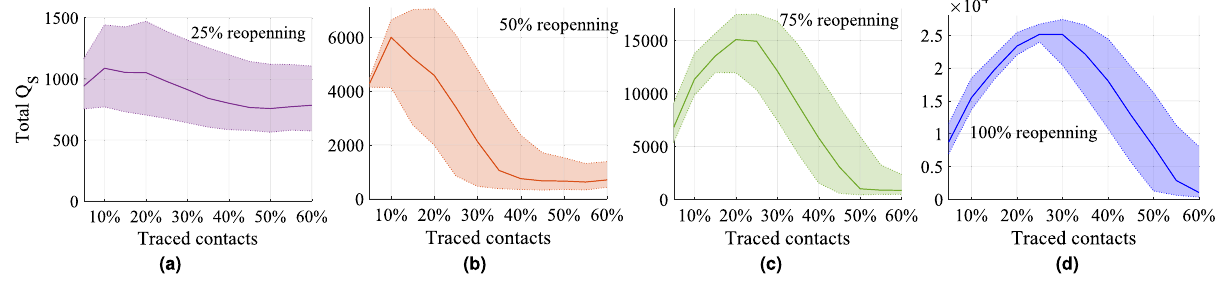
Figure 7. The total number of quarantined susceptible households in eight months after May 4, 2020, for the SEICQ1 epidemic model for the four reopening scenarios with different tracing levels. This figure is showing the median (solid lines) and interquartile range (shaded regions) of 1000 stochastic realizations.